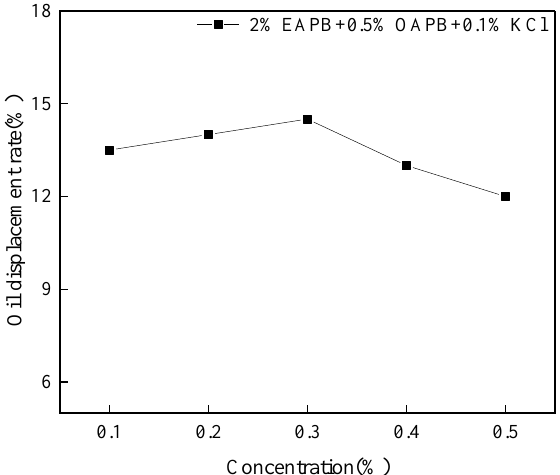
Figure 13. Oil displacement effect of surfactant gel.